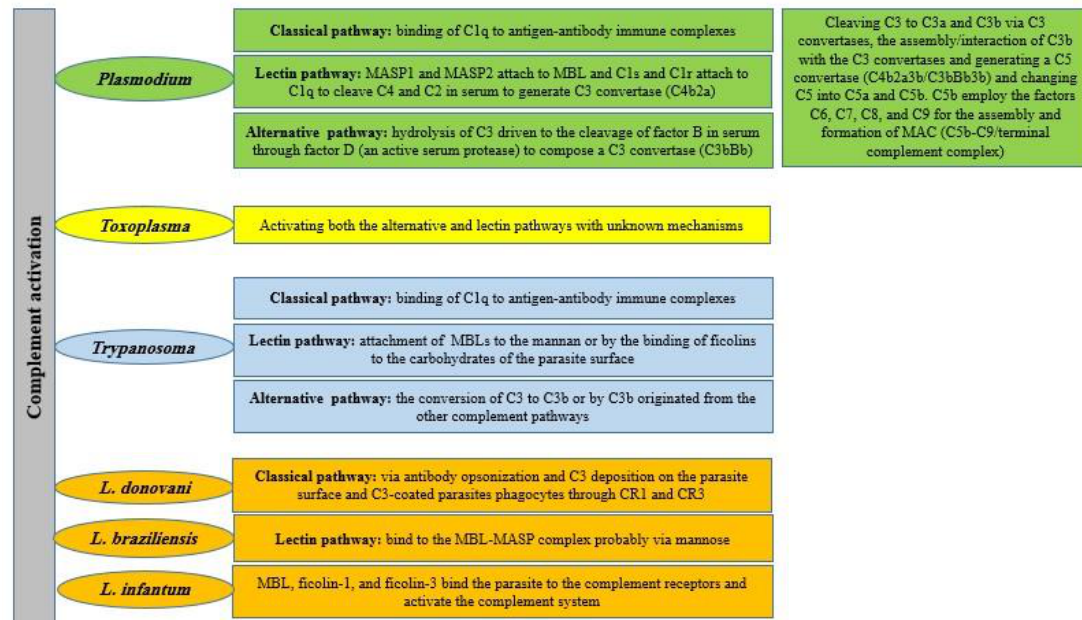
Figure 1. The activation of complement system: (a) the classical pathway is induced by the recogni- tion of antibody-antigen complexes on the pathogens surfaces through (by interacting with) com- plement component C1q, then cleaving C2 and C4 to produce C2a and C4b; these complement com- ponents bind to the pathogens surface to compose the C3 convertase C4b2a. (b) The lectin pathway in triggered by binding the mannose-binding lectin (MBL) or ficolin to mannan or glycosylated bi- omolecules, respectively (on the pathogens surface). The interaction of cysteine proteases with these biomolecules drive to the cleavage of C2 and C4 and thus generate the C3 convertase C4b2a. (c) The alternative pathway is initiated by spontaneously hydrolyzing C3b or C3b obtained from the other pathways, interacting with factor B, which is cleaved into Bb through factor D, and consequently composing the C3 convertase C3bBb [6,7].